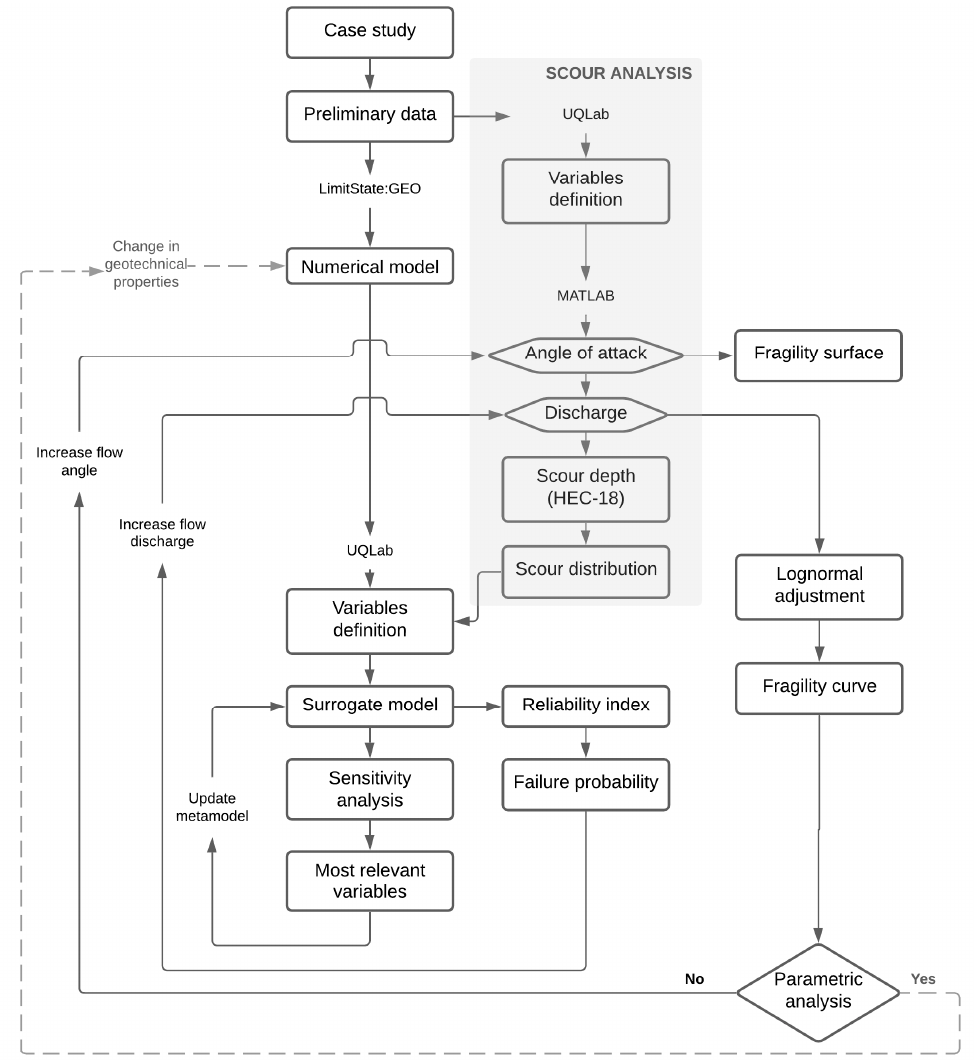
Figure 1. Framework for parametric fragility assessment of MAB under local scouring.